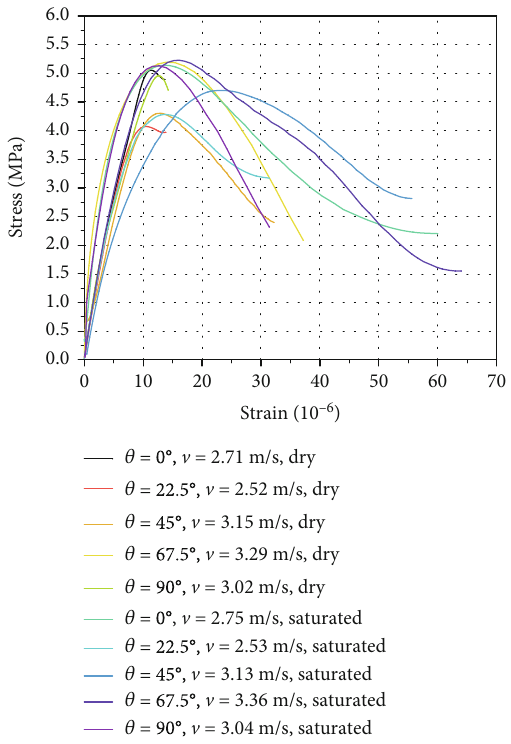
Figure 5: The stress-strain curves of coal specimens with di ff erent bedding